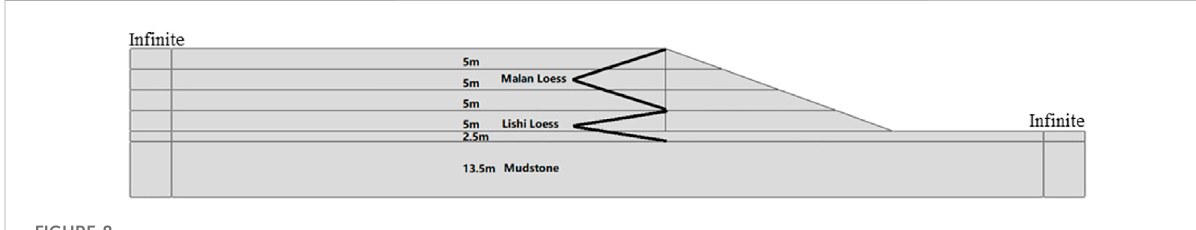
FIGURE 8 Structure of the fi nite-element 2D model of the prototype loess slope.